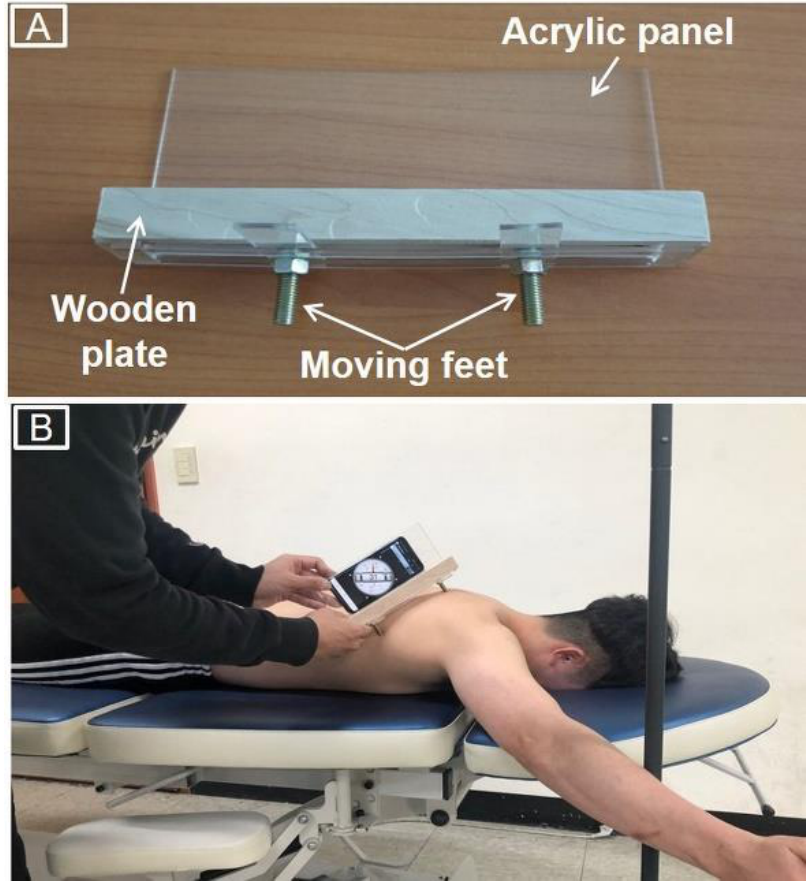
Figure 2. Custom-built measurement plate ( A ) and measurement of scapular posterior tilt using the custom-built measurement plate and an inclinometer ( B ).